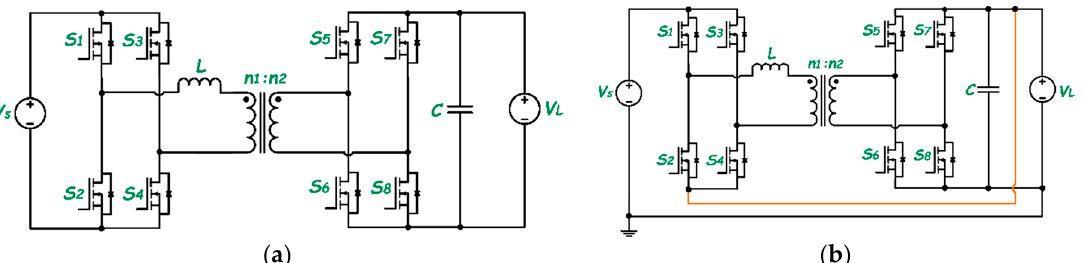
Figure 12. DC–DC converter based on DAB for fast-charging station; ( a ) FPP-DAB; ( b ) PPP-DAB.